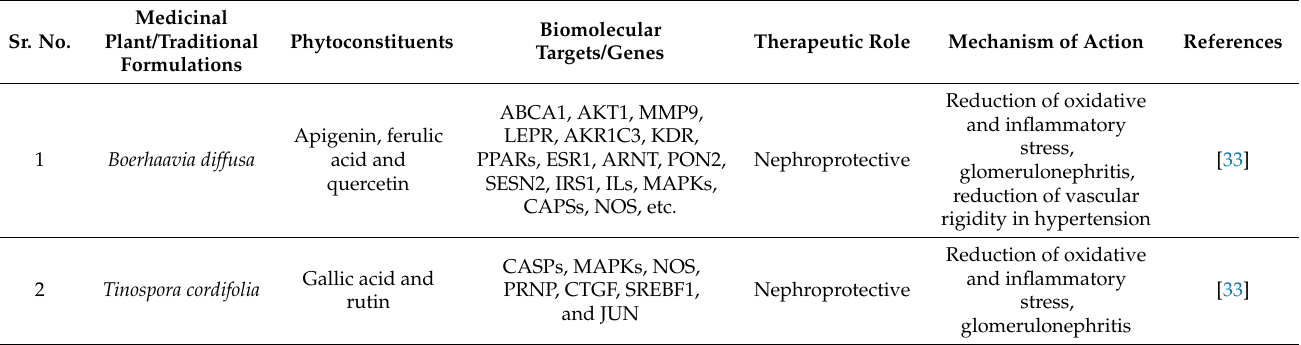
Table 3. Network pharmacology-based investigation of multi-targeted effects or molecular mecha- nisms of some herbal medicines or their derived